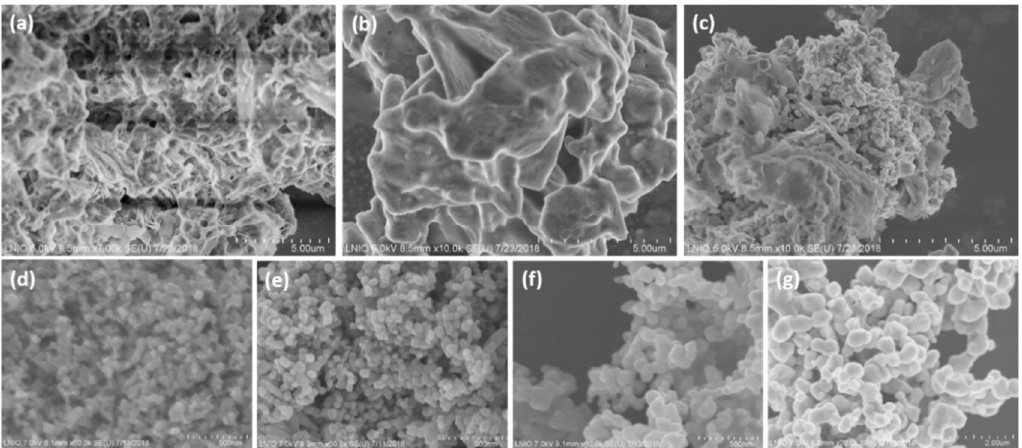
Figure 4. SEM images of the synthesized ZnO nanoparticles: ( a ) Without annealing and ( b–g ) annealed at 80, 100, 150, 250, 500 and 800 °C respectively. The scale bar in images (a–c) is 5 µm, ( d–f ) 500 nm, and ( g ) 2 µm.